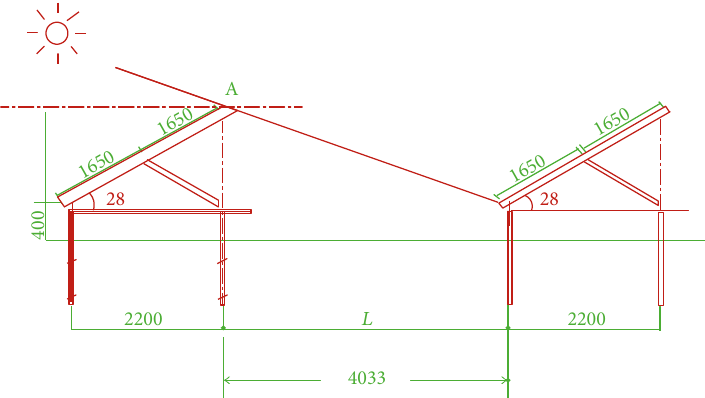
Figure 2: Support distance of PV mounting structure from the ground to the sun.